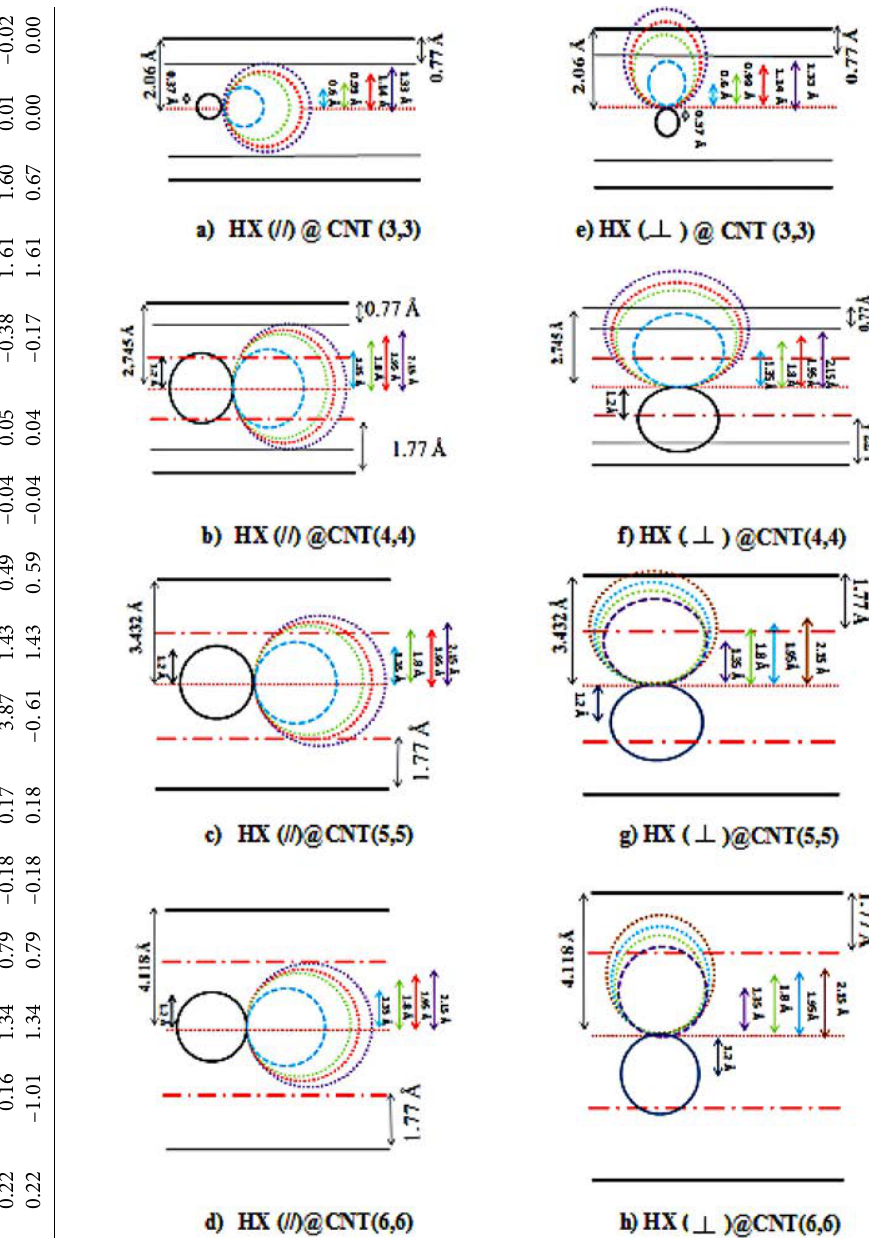
Figure 3. Schematic overlap between atomic/ van der Waals radius of the CNT and the confined hydrogen halides at both parallel and perpendicular